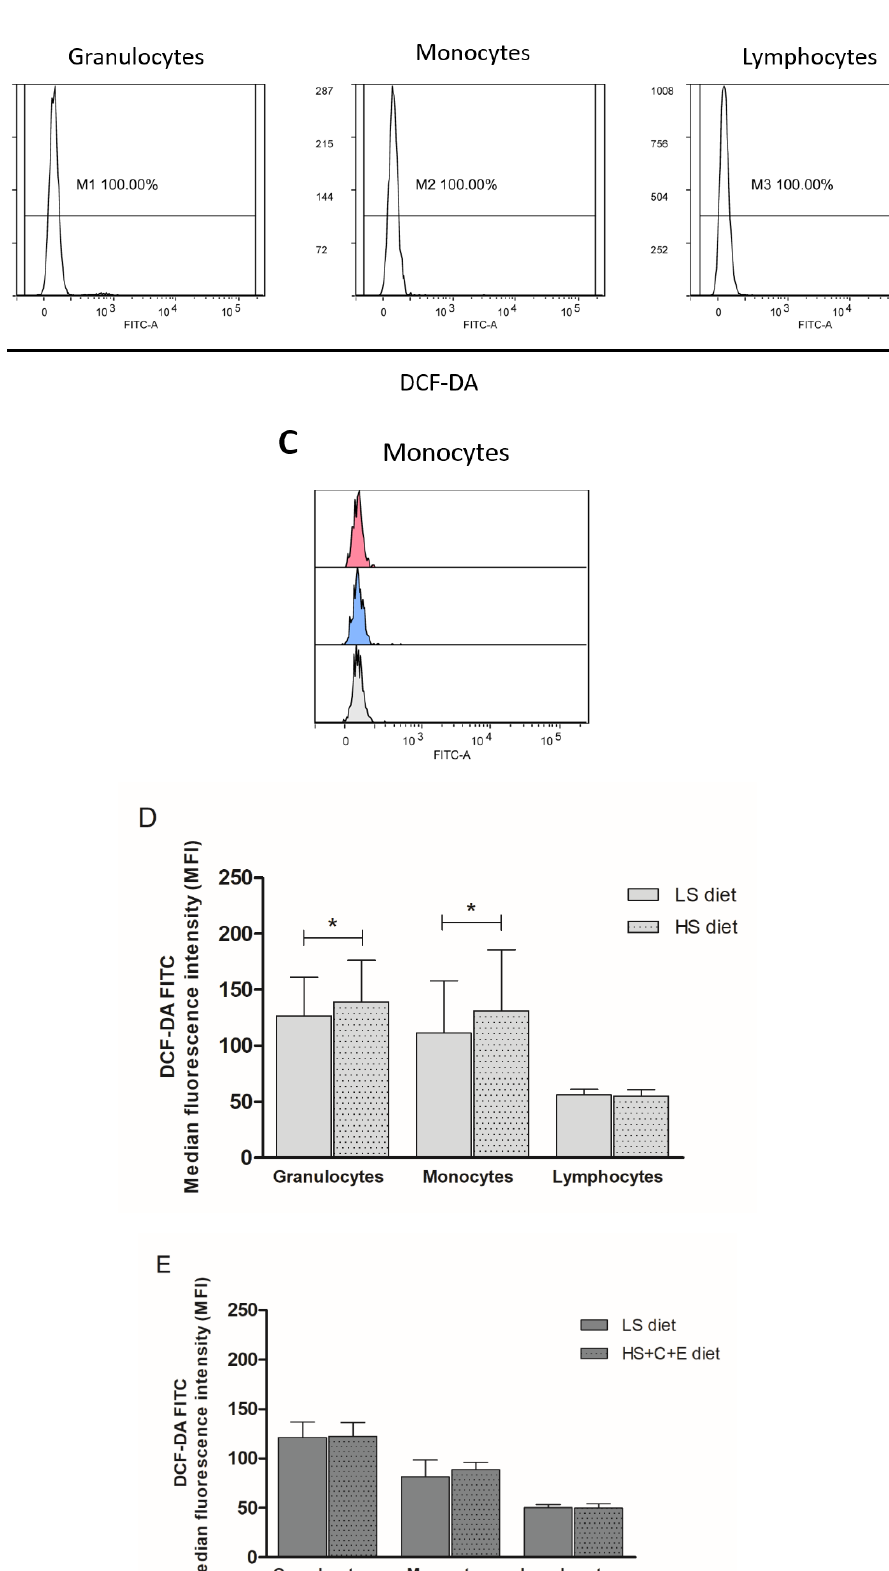
Figure 2. The e ff ect of the 7-day high-salt (HS) diet without (HS group) and with vitamin C and E (HS + C + E group) supplementation on hydrogen peroxide and peroxynitrite (DCF-DA) formation in peripheral blood leukocytes (PBL)—granulocytes, monocytes, and lymphocytes in young healthy individuals. ( A ) shows gating strategy for excluding doublets and defining leukocytes